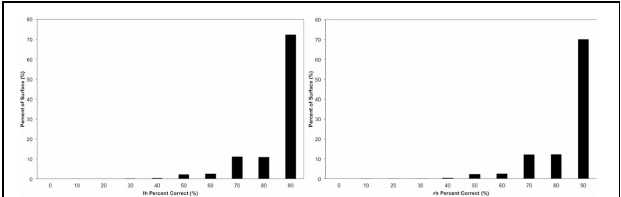
FIGURE 8 | The distribution of the accuracy in the atlas space. Each bin is labeled by the minimal value of it. For example, the first bin “0” represents accuracy 0 ∼ 10%, bin “10” represents accuracy 10% ∼ 20%, etc. The frequency is calculated by the number of vertices having accuracy represented by the bin.